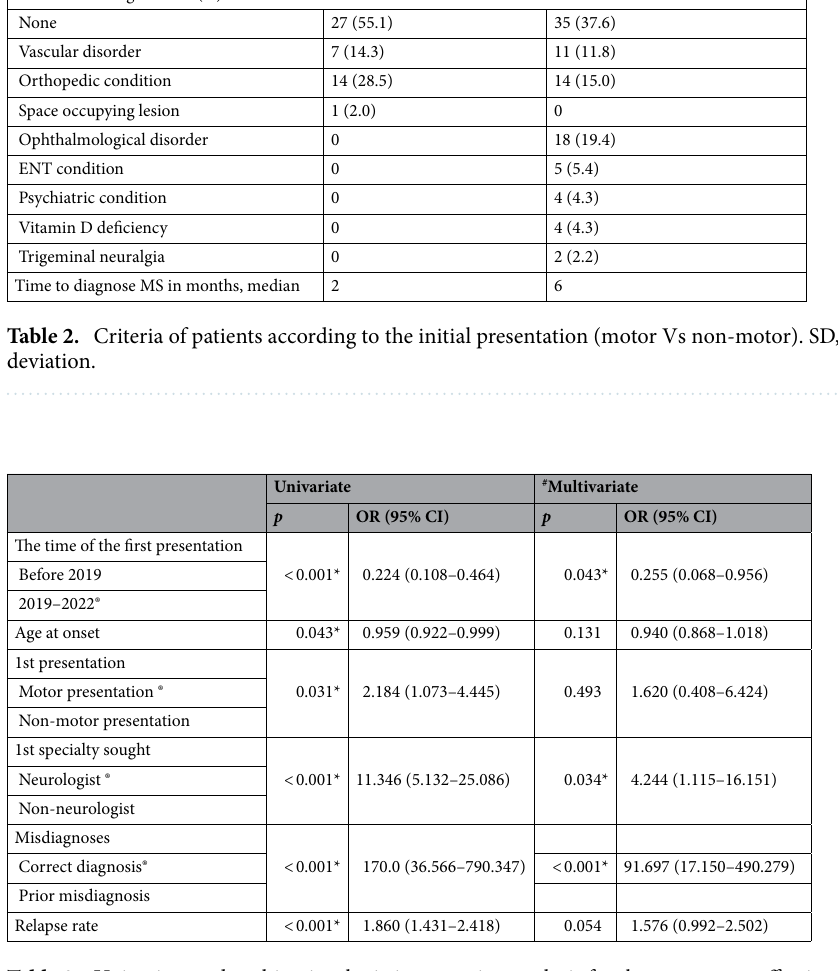
Table 3. Univariate and multivariate logistic regression analysis for the parameters affecting diagnostic delay in the bivariate analysis (n = 142). OR, Odd’s ratio; CI, Confidence interval. *Statistically significant at p ≤ 0.05. # All variables with p < 0.05 was included in the